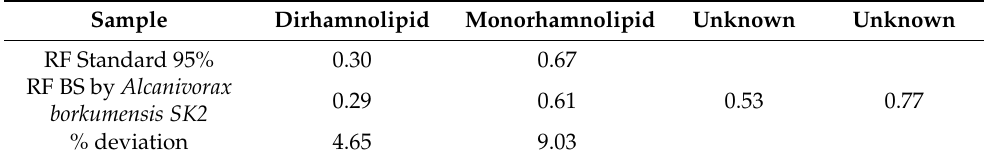
Table 1. RF values of standard rhamnolipids 95% and BS produced by Alkanivorax borkumensis SK2